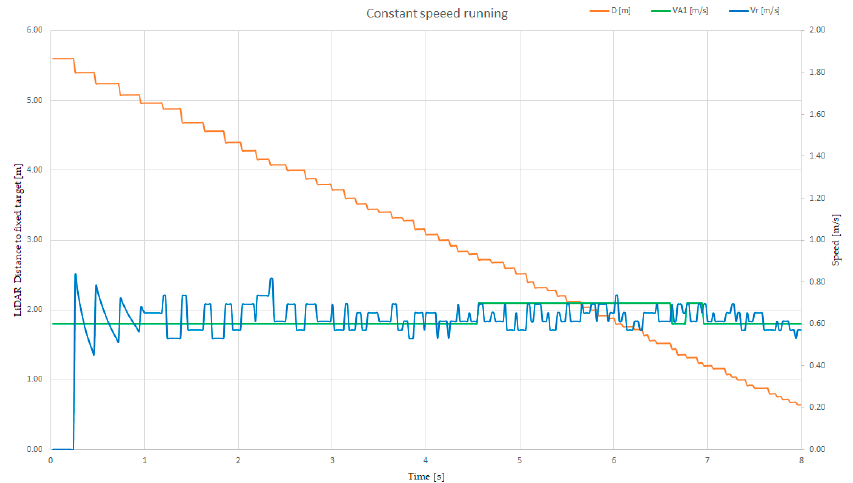
Figure 17. Plot of the distance (orange), relative speed (blue) and actual speed (green) of the tram with a LiDAR sensor, at constant running speed. with a LiDAR sensor, at constant running